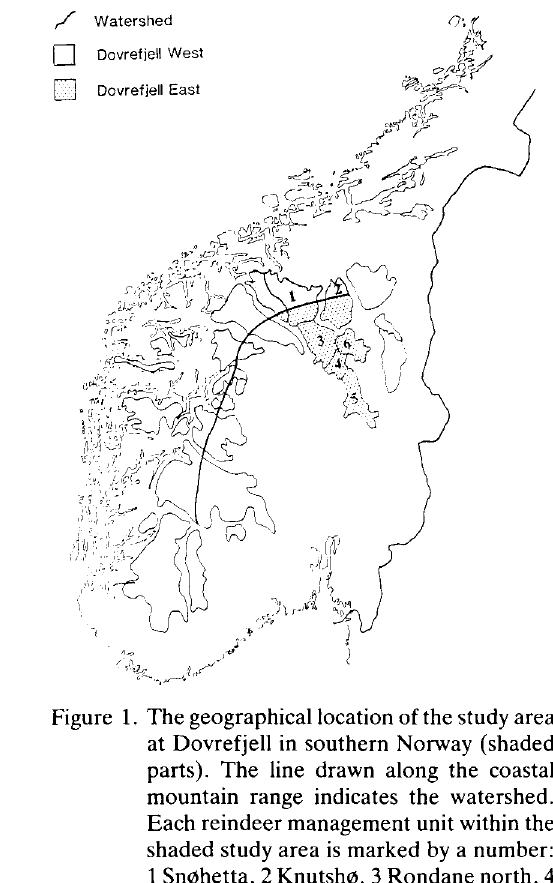
gements units in southern Norway are also shown on the map. Figur 1. Beliggenheten av undersøkelsesområdet på Dovrefjell i Sør-Norge (skyggede partier). Den tykke linjen langs fjellkjeden angir vannskillet. Hvert villreinområde er markert